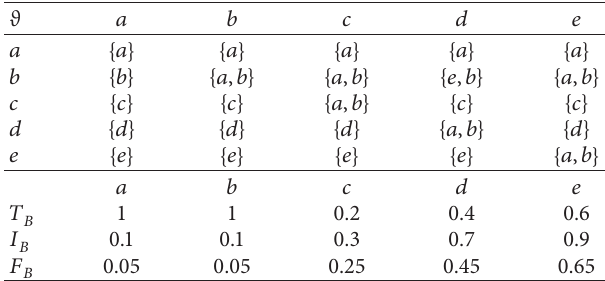
Table 5: Single-valued neutrosophic hyper BCK-subalgebra of a data